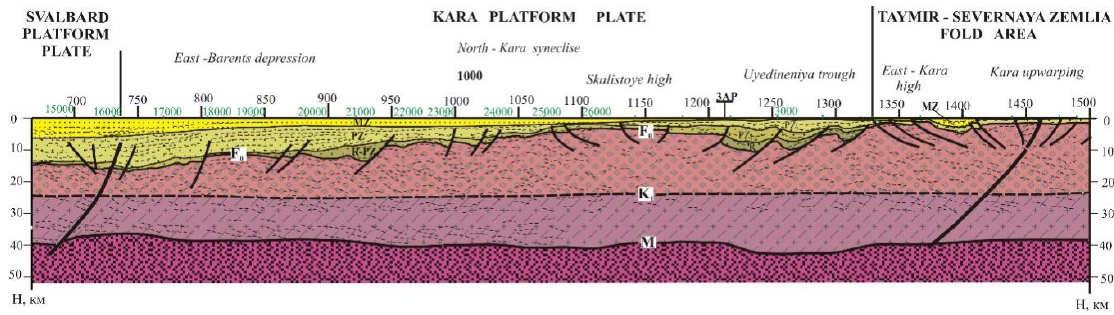
Figure 6. Section of the Earth's crust of the Kara platform and the Taimyr-Severozemelskaya fold zone (southeastern fragment of the AR-4 geo-traverse). Compiled using materials of State enterprise "Sevmorgeo" [8]. See Figure 2 for legend.